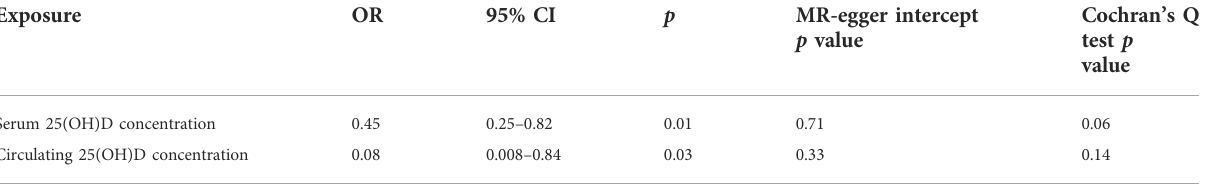
TABLE 4 Inverse variance weighted estimates for positive control